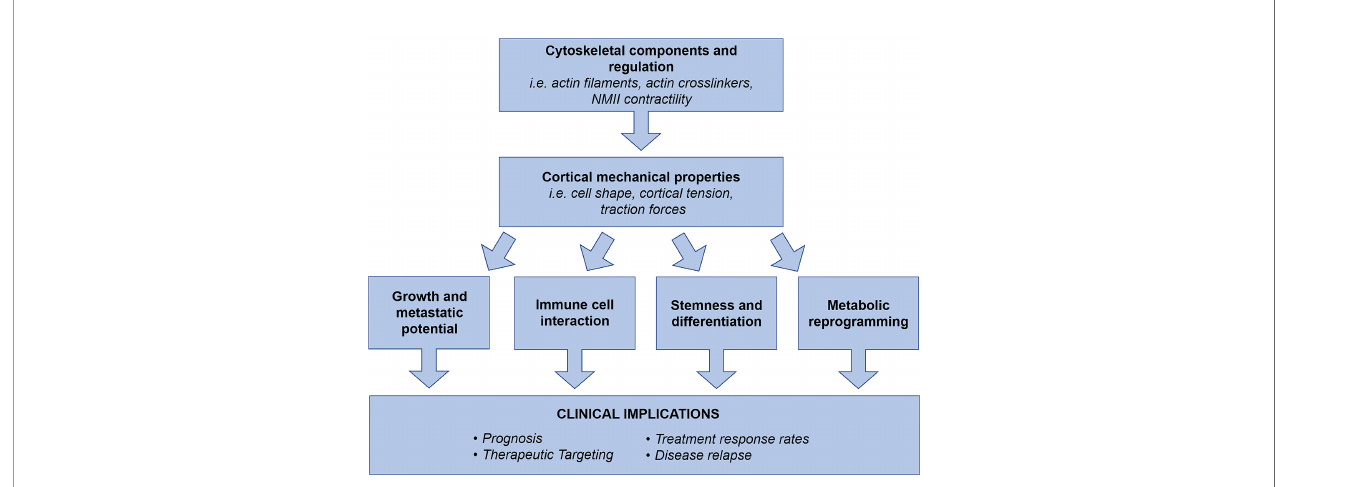
FIGURE 2 | Cell cortical mechanics and its molecular drivers generate cell shape and morphogenesis, which collectively result in observed cell behaviors. The mechanical landscape and properties of cancer cells are signi fi cantly altered to drive metastasis and disease progression. Collectively, cytoskeletal components, regulators, and their resulting physical properties have been revealed as regulators of cancer cell growth and metastatic potential, TME interactions, stemness and differentiation, and metabolic reprogramming. Therefore, we propose the fi eld of cancer cortical mechanics as a prospective area for exploration in disease prognosis, therapeutic targeting, elimination of therapeutic resistance, and prevention of clinical relapse. As a foundational system of cell behavior, cortical mechanics has the potential to concurrently address multiple drivers of disease progression, which is an ideal strategy for treating aggressive and unresponsive cancer types such as